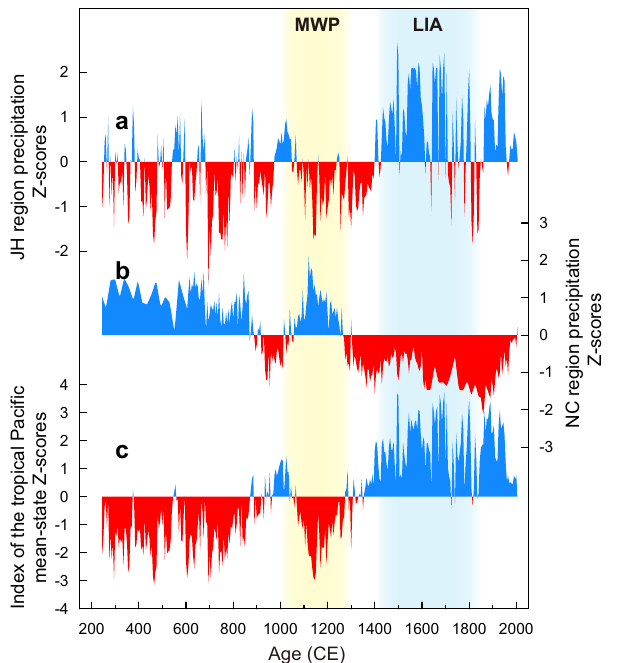
Fig. 2 Index of the tropical Paci fi c mean-state reconstruction over the past 1800 years from precipitation anomalies in East Asia. a Normalized precipitation record based on sediments redness (a*/L* ratio) from Lake Nvshan, in the JH region of east-central China 41 , b normalized pollen-based precipitation reconstruction from Lake Gonghai in the NC region of northern China 45 , c index of the tropical Paci fi c mean-state as the difference between the reconstructed precipitation records from Lake Nvshan and Lake Gonghai. High precipitation and positive index are colored blue and low precipitation and negative index are colored red. The MWP period is shaded in yellow, and the LIA period is shaded in light blue. The index of the tropical Paci fi c mean-state time series derived from lake sediments in the JH and NC regions of East Asia closely covaries with the time series of the zonal SST gradient in the tropical east-west Paci fi c 46 ( r = − 0.76, p < 0.01), the composite δ 18 O Z-scores of speleothems in the AAM region 47 ( r = 0.42,